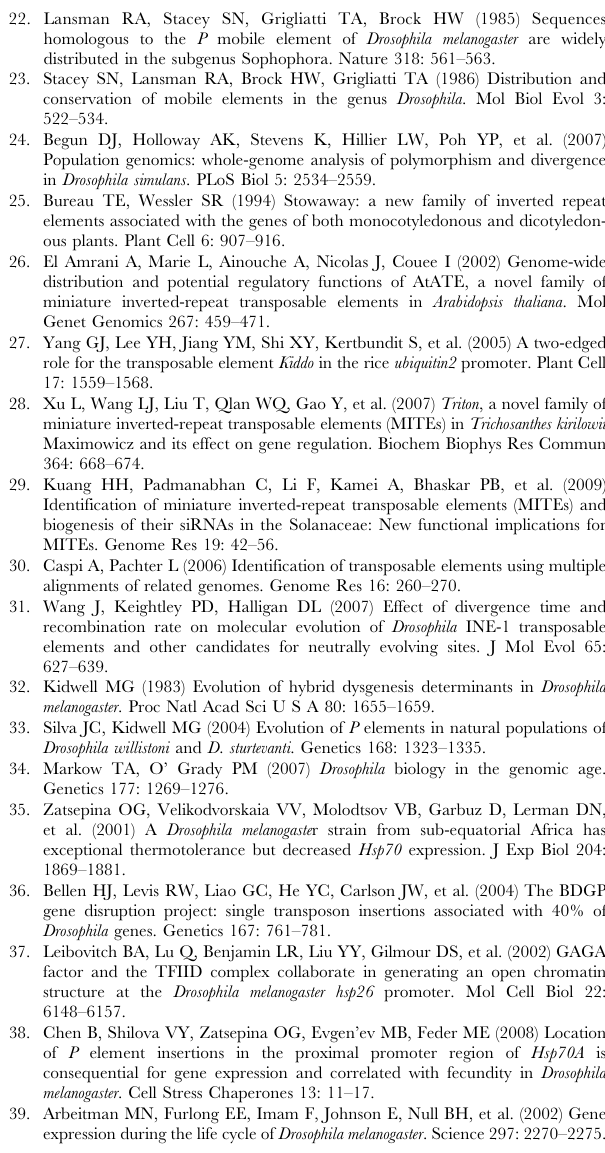
and the TE sequence contained within it are tabled. Coordinates are from genome releases as detailed in the text. The first sheet contains insertions in promoters from all single copy genes, while insertions from the multicopy hsp70 genes are listed in the second sheet. Table S6 Values of test statistics, degrees of freedom where applicable, and significance level for statistical